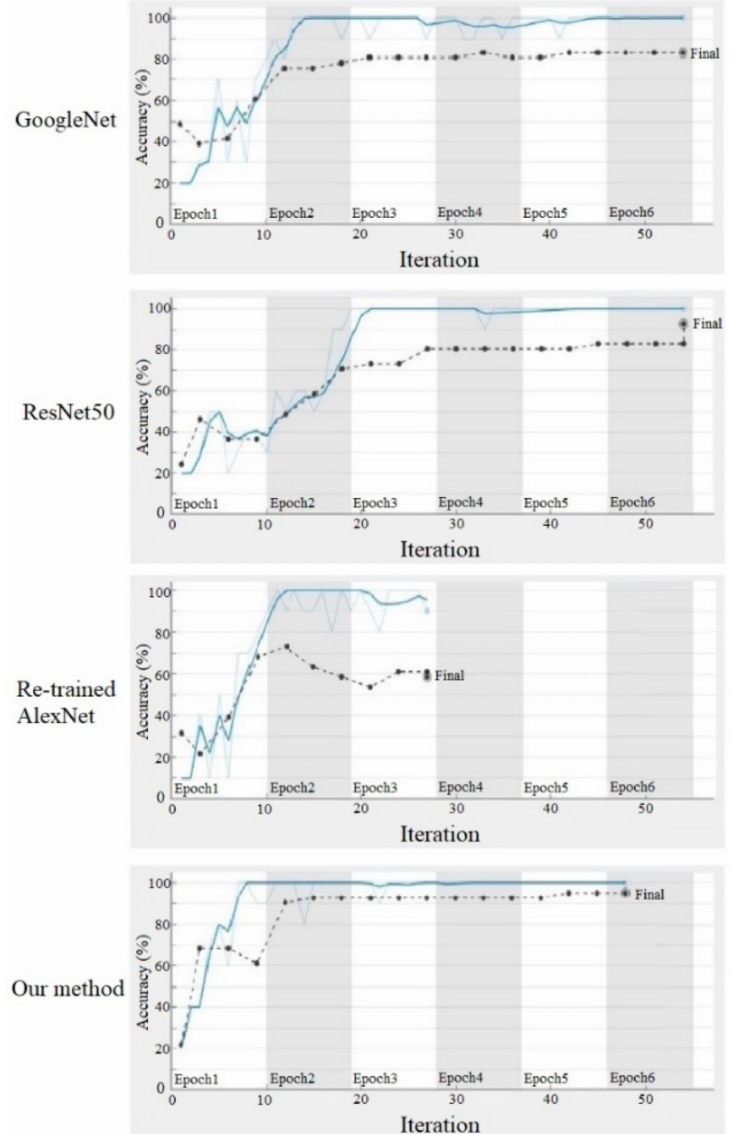
Figure 12. Accuracy curve of different